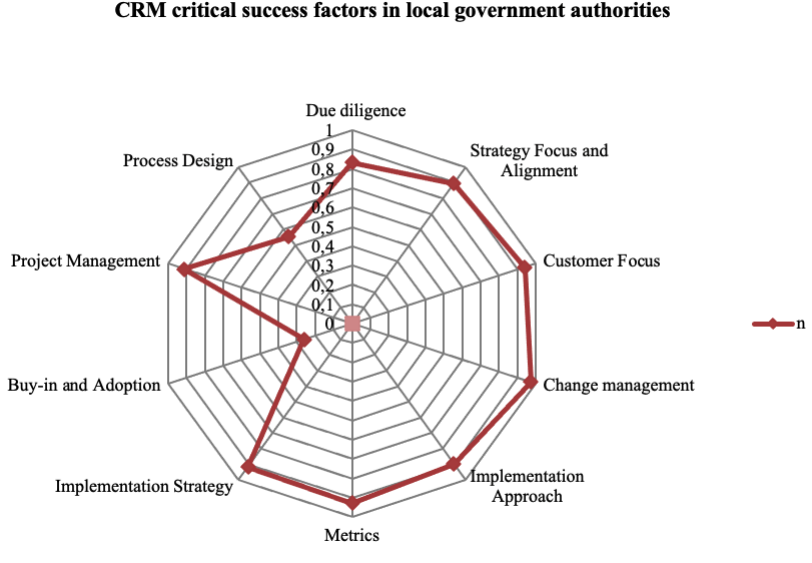
Figure 2: CRM critical success factors in the local government authorities; Source: